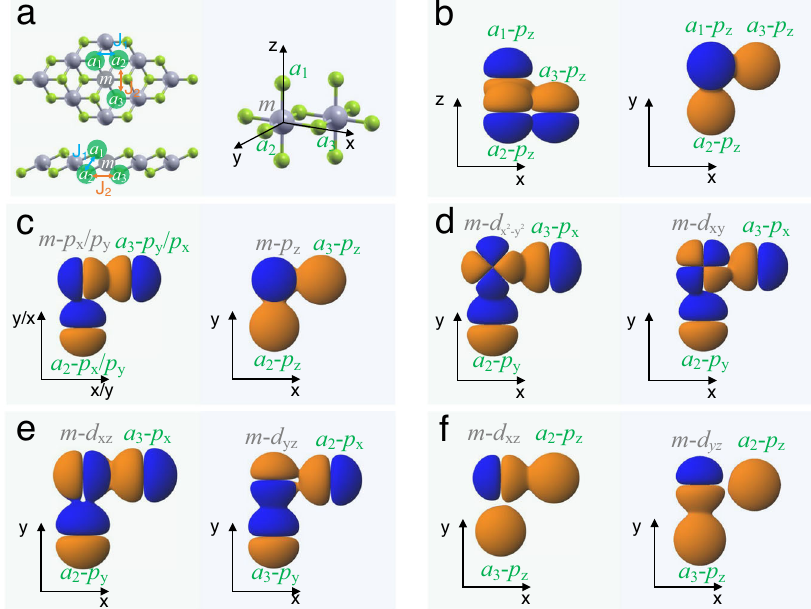
Fig. 6 Schematic diagram of the magnetic exchange interactions. a Exchange interaction paths in P3m1 metal dihalides. J 1 is the exchange coupling parameter originated from the halide ions on the upper layer ( a 1 ) and the bottom layer ( a 2 ). J 2 is the exchange coupling parameter originated from the halide ions on the same atomic plane ( a 2 and a 3 ), m is the metal ions. Edge-sharing distorted ma 6 octahedra with the local xyz coordinates of the P3m1 structure are also given on the right. Schematic diagrams of ( b ) direct exchange between halogen- p z orbitals, ( c ) the super-exchange interactions between halogen- p x / p y orbitals with metal- p x / p y orbitals and halogen- p z orbitals with metal- p z orbitals, ( d ) halogen- p x / p y orbitals with metal- d x 2 (cid:2) y 2 / d xy orbitals, ( e ) halogen- p x / p y orbitals with metal- d xz / d yz orbitals, and ( f ) halogen- p z orbitals with metal- d xz / d yz